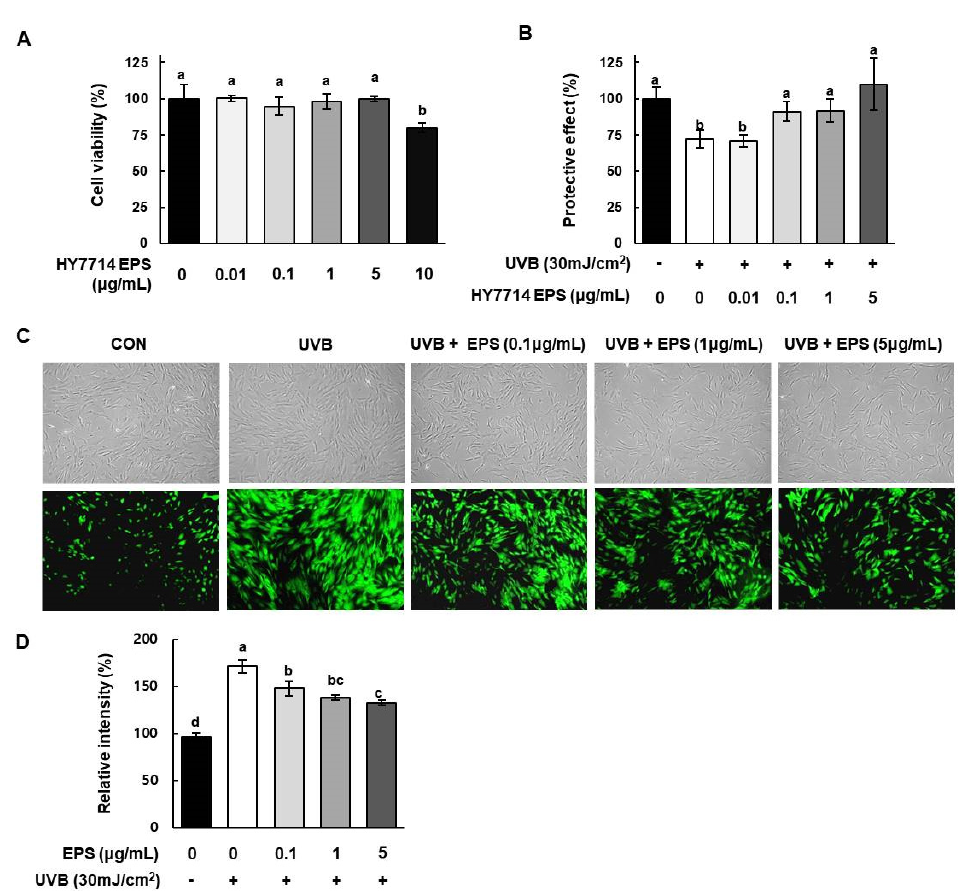
Thus, HY7714 EPS treatment may have antioxidant effects in UVB-irradiated skin fibroblasts.